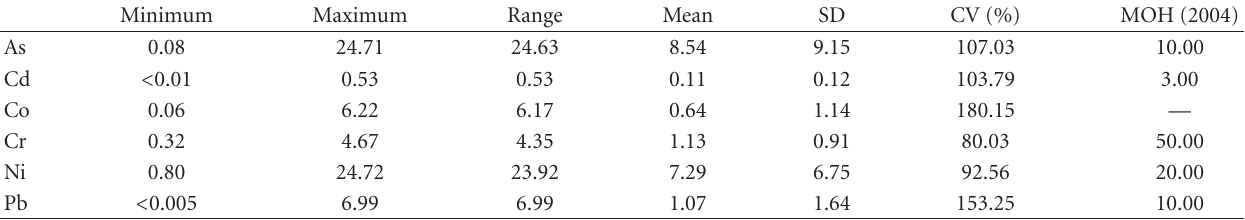
Table 5: Descriptive statistic of heavy metal concentrations ( µ g/L) in water samples at Langat River ( n =